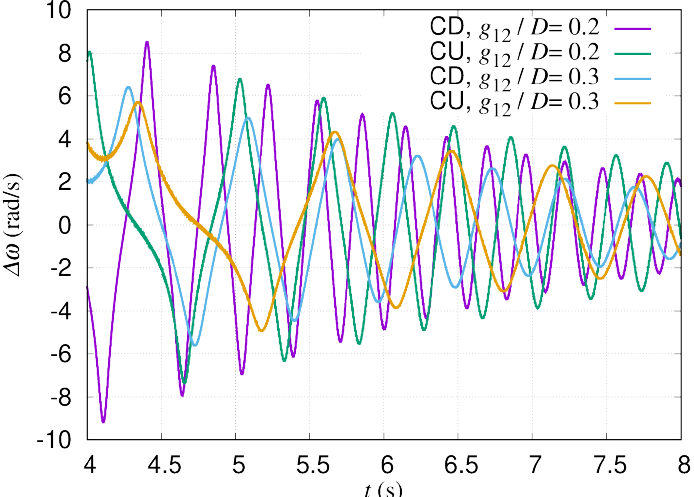
Figure 10. Time evolution of difference of angular velocities ∆ ω : = | ω 1 | − | ω 2 | is shown. The oscillation period is longer for larger gap distances, as well as for the CU layout compared with the CD